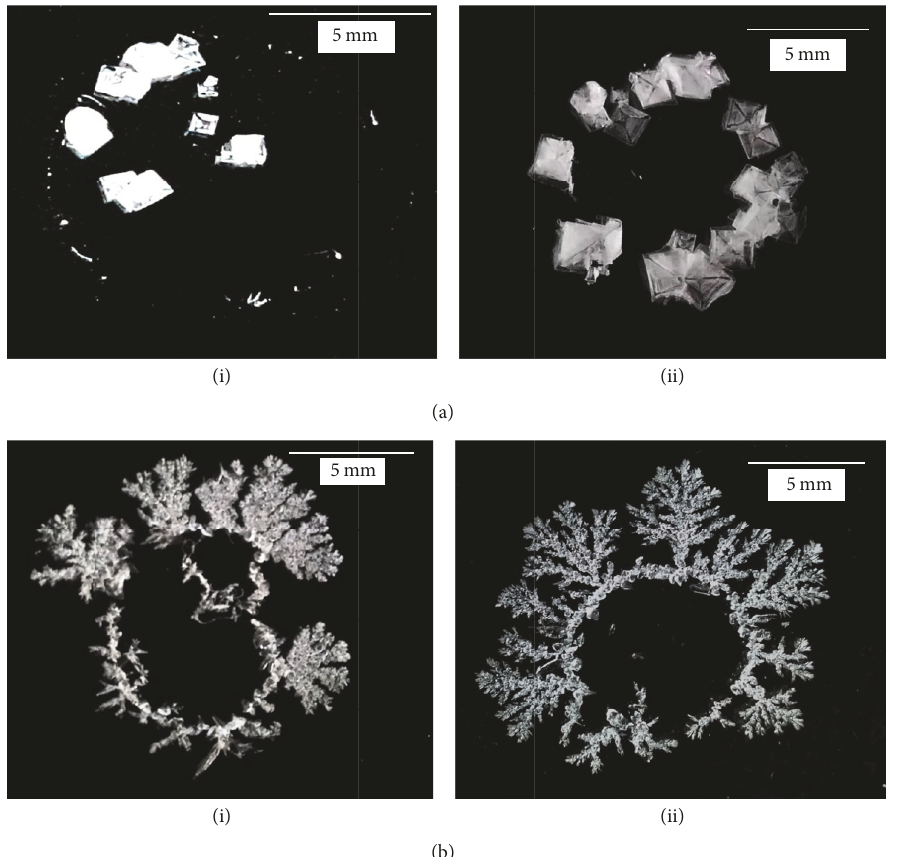
Figure 7: (a) and (b) are dried drops (50 𝜇 l) of NaCl and Na 2 SO 4 solutions on Piranha treated glass substrates. (i) and (ii) represent different concentrations (0.05 M and 0.1 M, resp.) of salts in the